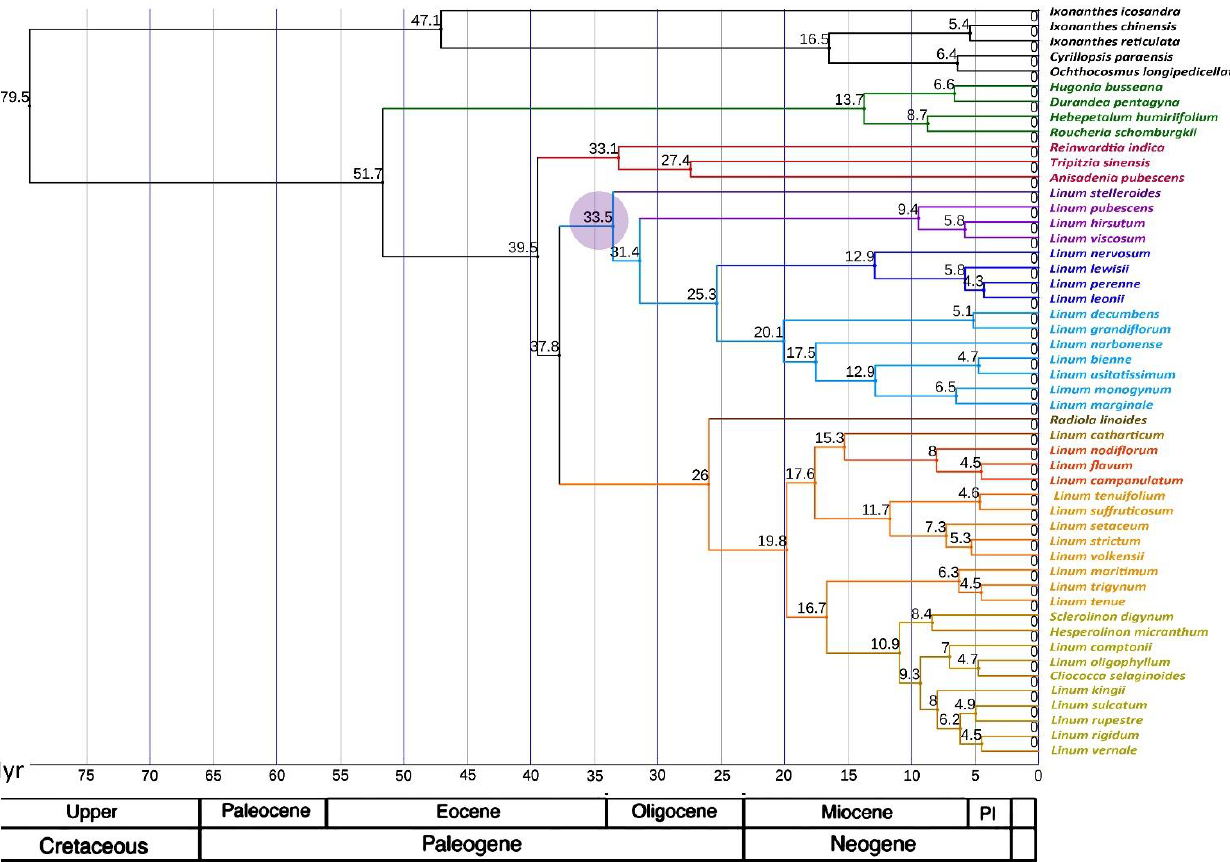
Figure 4. Bayesian chronogram of 45 taxa of Linaceae and 5 taxa of Ixonanthaceae . The values shown above branches are the dates of the nodes. The purple circle marks the point of the sect. Stellerolinum divergence from the common trunk of the blue-flowered flax. Pl on the geochronological scale — Pliocene.